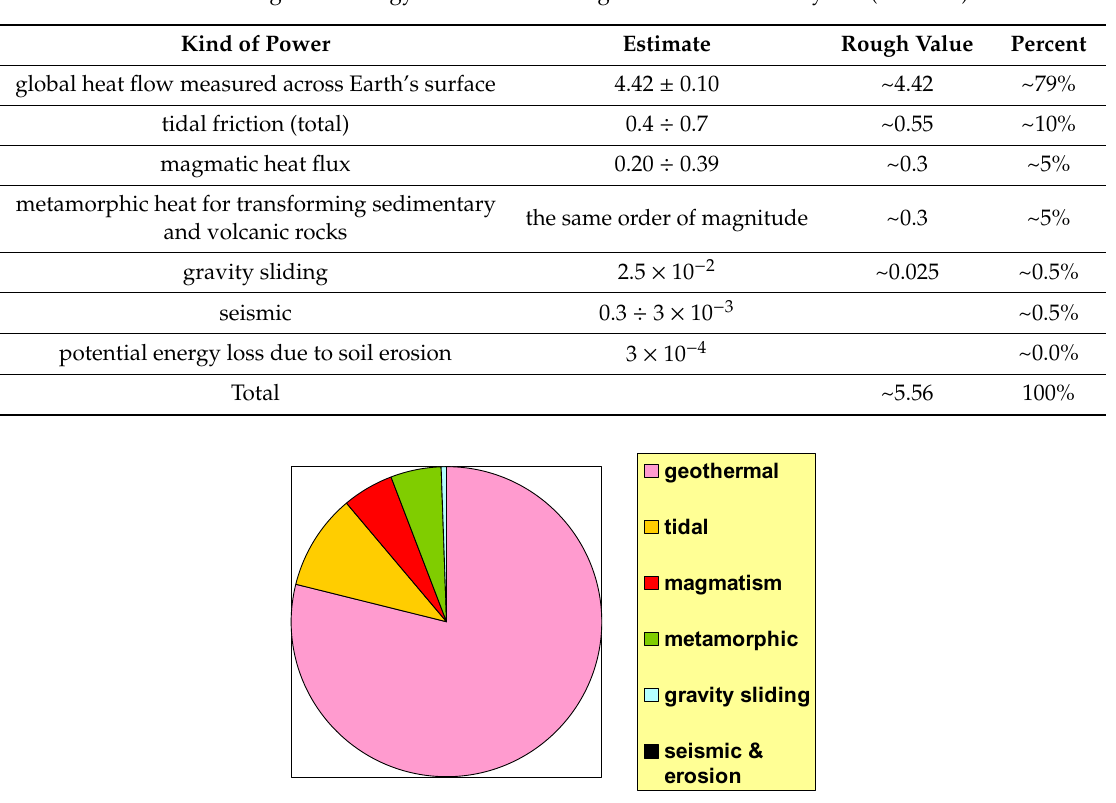
Figure 1. Relative role, during the last few million years, of different kinds of endogenous energy manifested in Earth phenomena (see Table 1).